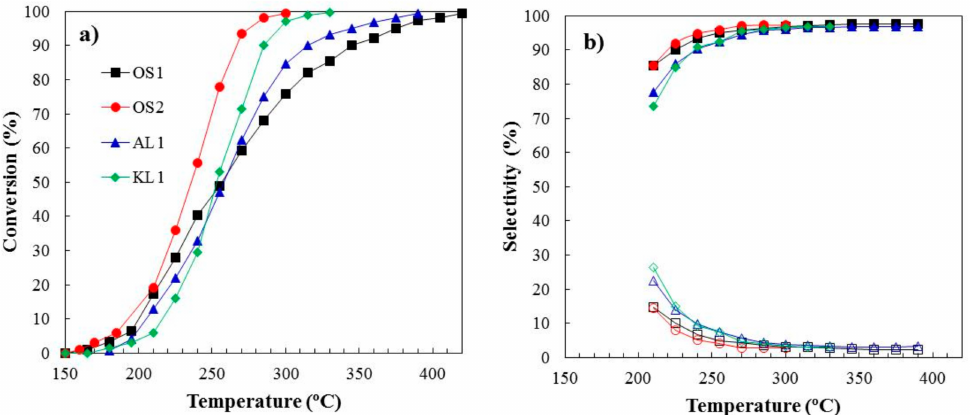
Figure 4. ( a ) 2-Propanol steady state conversion and ( b ) selectivity to propylene (filled marks) and diisoppropyl ether (hollow marks) as a function of the reaction temperature for the di ff erent carbon monoliths catalysts under inert atmosphere. P 0IPA = 0.03 atm; W / F 0IPA = 0.1 g · s / µ mol.